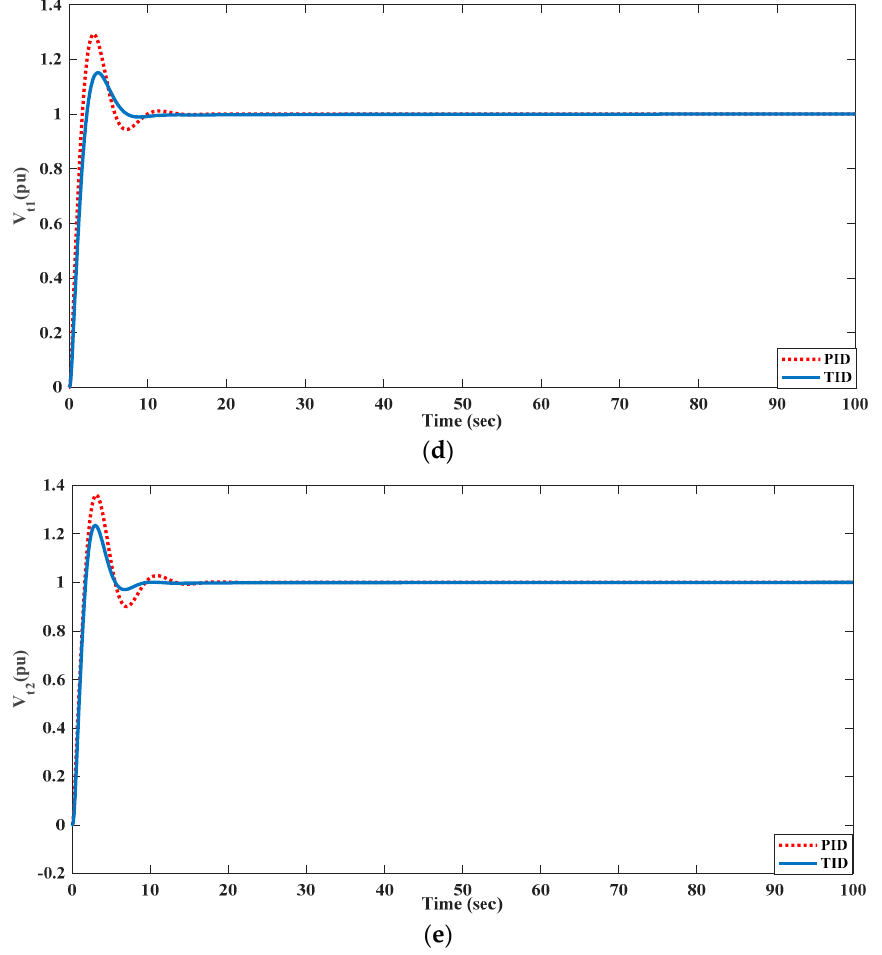
Figure 20. System dynamics for the combined AGC and AVR system. ( a ) Δ f 1 ; ( b ) Δ P tie ; ( c ) Δ f 2 ; ( d ) V t1 ; ( e ) V t2 . Table 15. PID parameters for the combined AGC and AVR system. Table 17. Comparison of AGC dynamics for PID and TID controllers.